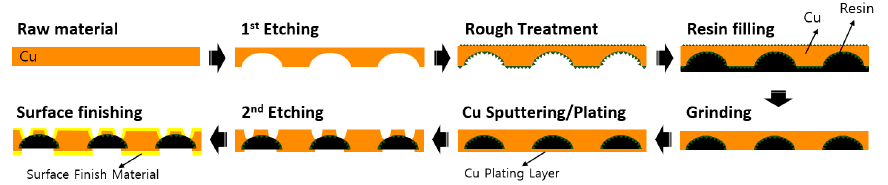
Figure 1. Schematic diagram of two-layer Rt-QFN Manufacturing Process.